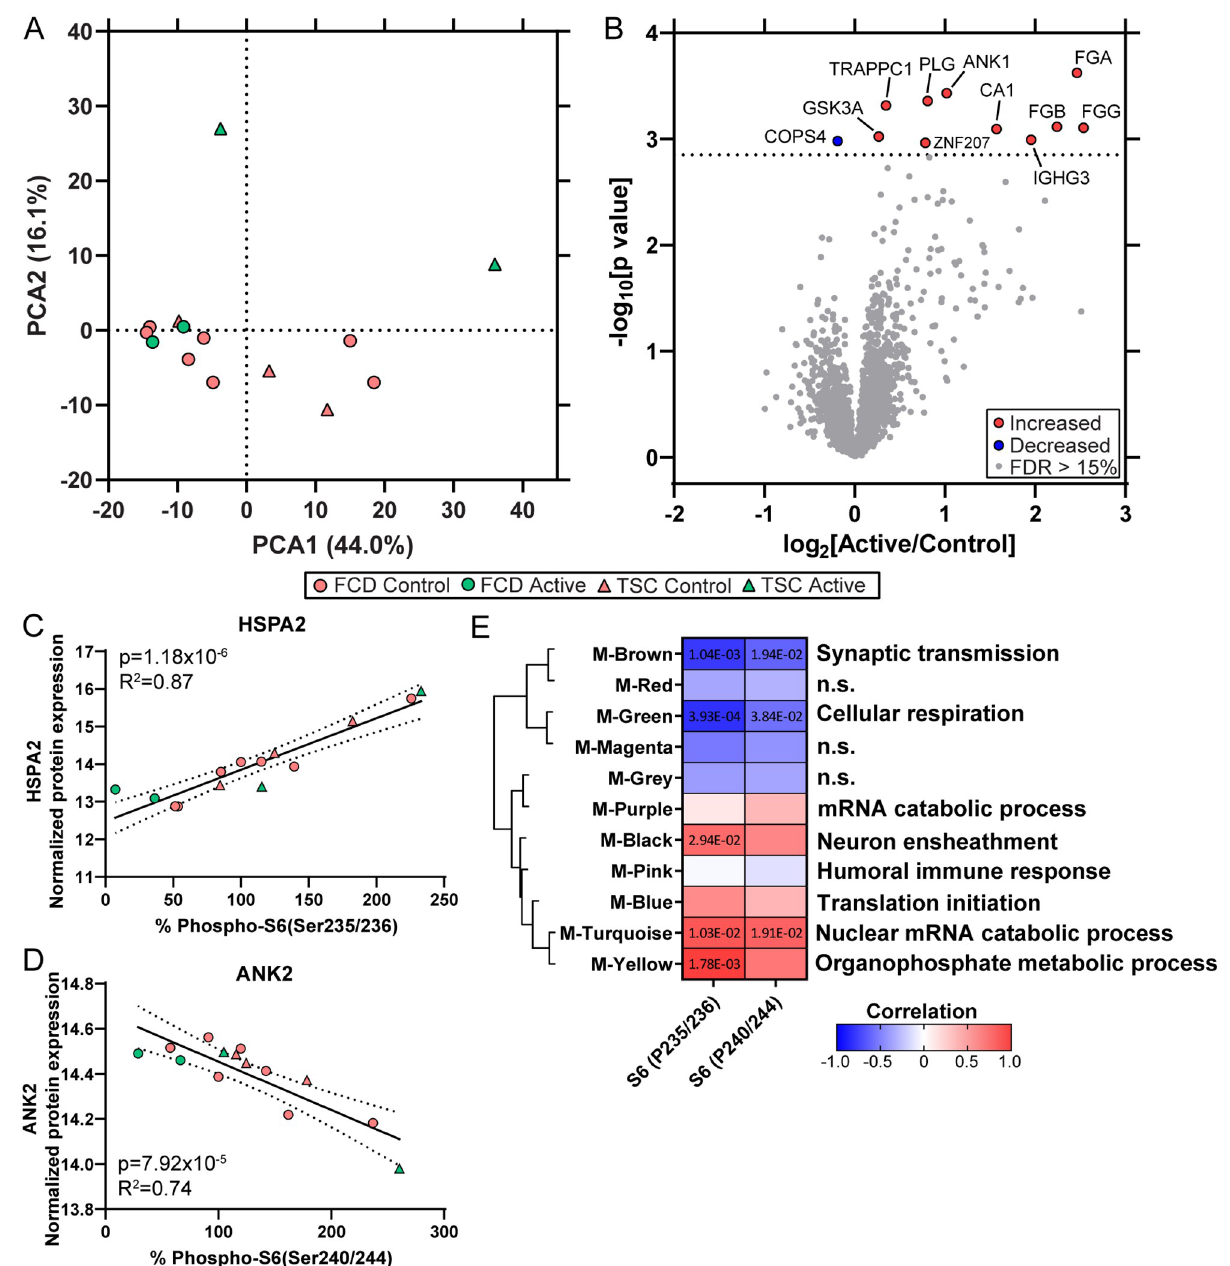
Fig 3. Proteomics in whole brain homogenate. Proteomics was performed in surgically resected brain tissue from Active and Control participants. A) PCA in brain tissue indicated no segregation of Active and Control participants in PCA1 (p = 0.73) and with some segregation in PCA2 (p = 0.016). Clinical diagnoses (FCD, TSC) are noted as well. B) Differential expression analysis in brain tissue indicated that there were 11 significantly altered proteins in Active versus Control participants at an FDR < 15% (dotted line), detailed in S1 Table and S1 Fig. There were no significant proteins at FDR < 5–10%. C) WGCNA of brain proteomics and phospho-S6 evaluated in total brain homogenate by western blot, regardless of everolimus and clinical diagnoses. There were 1109 proteins that correlated with phospho-S6 levels (P235/236, p < 0.05), distributed across 10 modules (all but M-Purple). The top significantly correlated protein with P235/236 was a positive correlation to HSPA2 (p = 1.18 x 10 − 6 , R 2 = 0.87) in the M-Brown module. D) The top significantly correlated protein with P240/244 was a negative correlation with ANK2 (p = 7.92 x 10 − 5 , R 2 = 0.74) in the M-Brown module. E) Module trait correlation identified 5 significantly associated modules with phospho-S6 (p < 0.05). Modules were clustered by eigenprotein adjacency (relatedness to other modules) on the left. Name of module is indicated by “M-color.” P values are indicated for those modules with p < 0.05 correlation. Positive correlation is indicated in red and negative correlation in blue. Top module GO annotations are noted on the right (FDR < 5%, at least 5 proteins/annotation). Several modules did not have a significant GO annotation (“n.s.”).